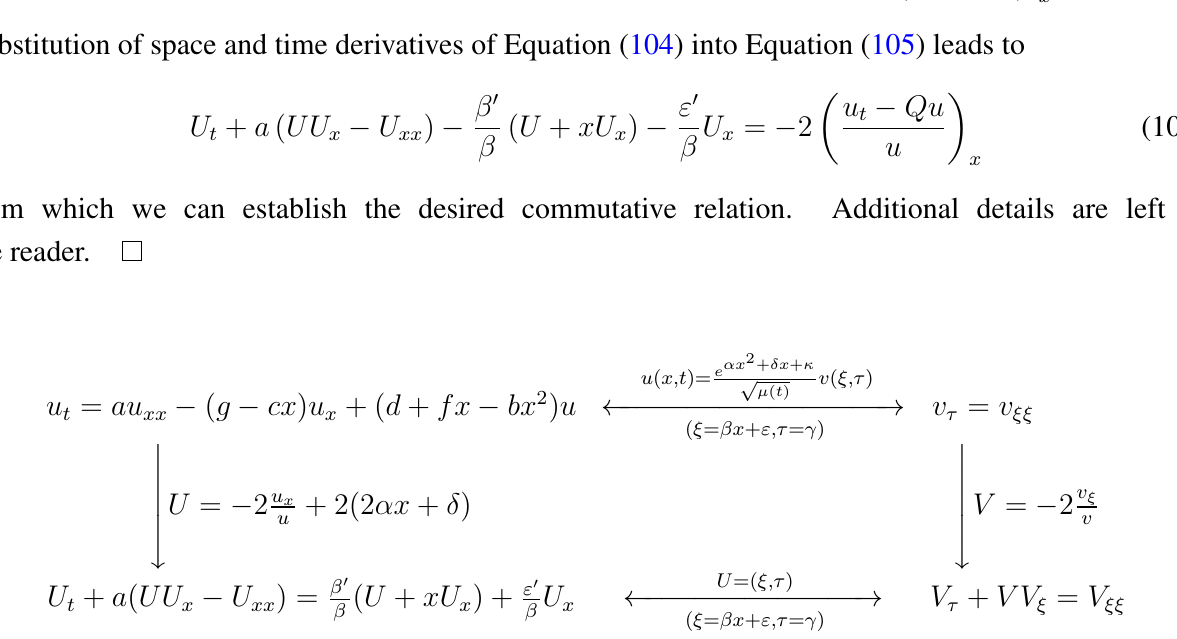
Diagram 1. A diagram summarizing the relations between the non-autonomous and inhomogeneous diffusion-type equation (6), the linear heat equation (7) and the Burgers-type equations (102) and